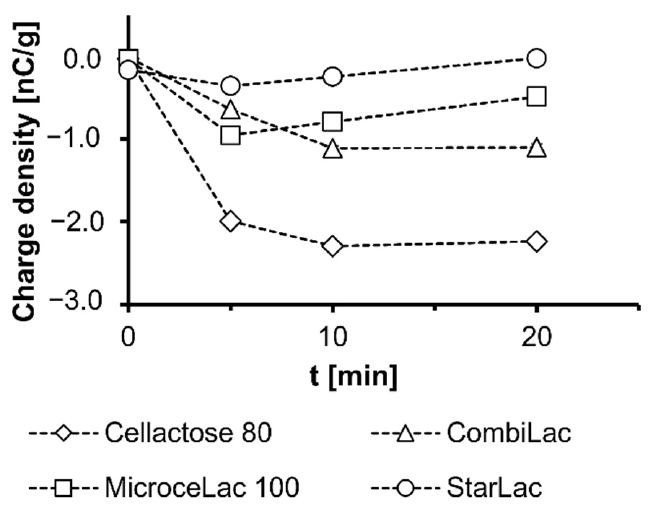
Figure 5. Charge density throughout blending.